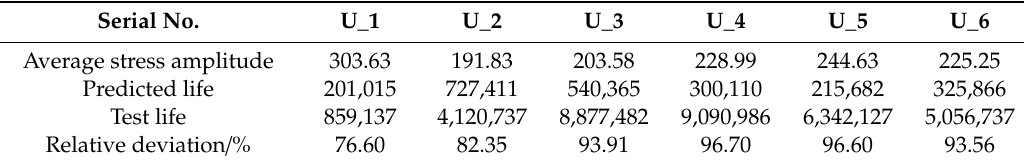
Table 12. Measured average stress amplitude and predicted life N 4.